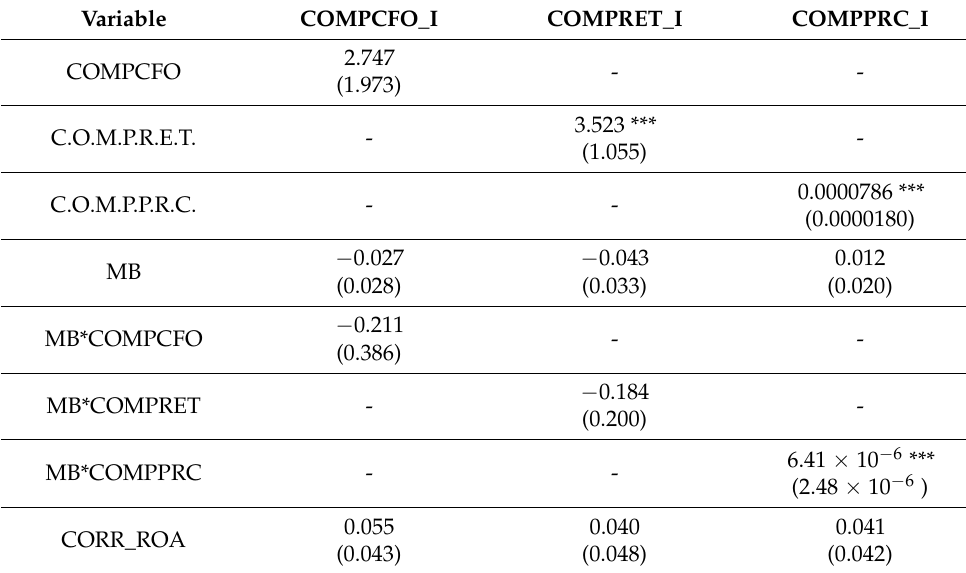
Table 5. Compensation and accounting comparability: unconditional